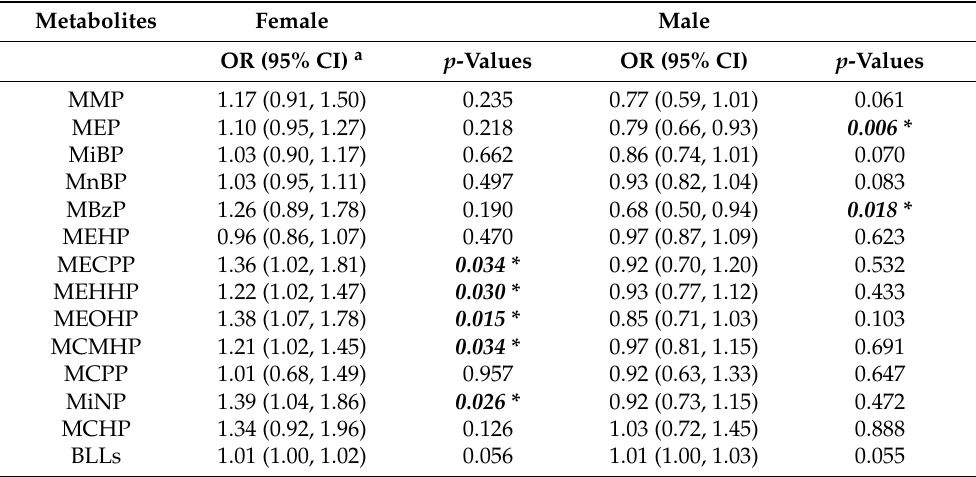
Table 4. Adjusted ORs for urinary phthalate metabolites, blood lead levels, and thyroid nodule stratified by gender.